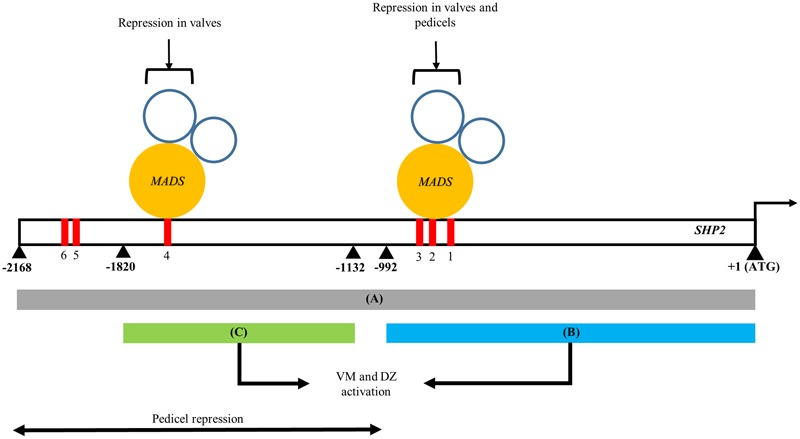
A model of the spatio-temporal transcriptional regulation of SHP2. Regions A, B, and C of the SHP2 promoter correspond to the 2.2kb (pSHP22kb), 1kb (pSHP21kb) and 700bp (pSHP2700b) fragments assayed in promoter-reporter fusions within this work. Region A contains cis regulatory elements that promote early medial, early and late VM and DZ expression during floral development. Both regions B and C are redundant, non-overlapping and non-sequence homologous enhancers that both promote VM- and DZ- specific expression of SHP2, contributing to the robustness to the promotion of SHP2 activities in these tissues. The region upstream of B putatively contains repressor elements for SHP2 pedicel- specific expression. Mutations introduced into CArG boxes 1-3 indicate that these sites mediate repression of SHP2 in the basal valve domains during VM development and also facilitate repression of SHP2 in the pedicels. Region C contains CArG box 4 may be sufficient to mediate proper repression of SHP2 in the valves during VM development. +1 denotes the start of the SHP2 translation start site. Numbers denote number of nucleotides upstream from the start of translation of SHP2.